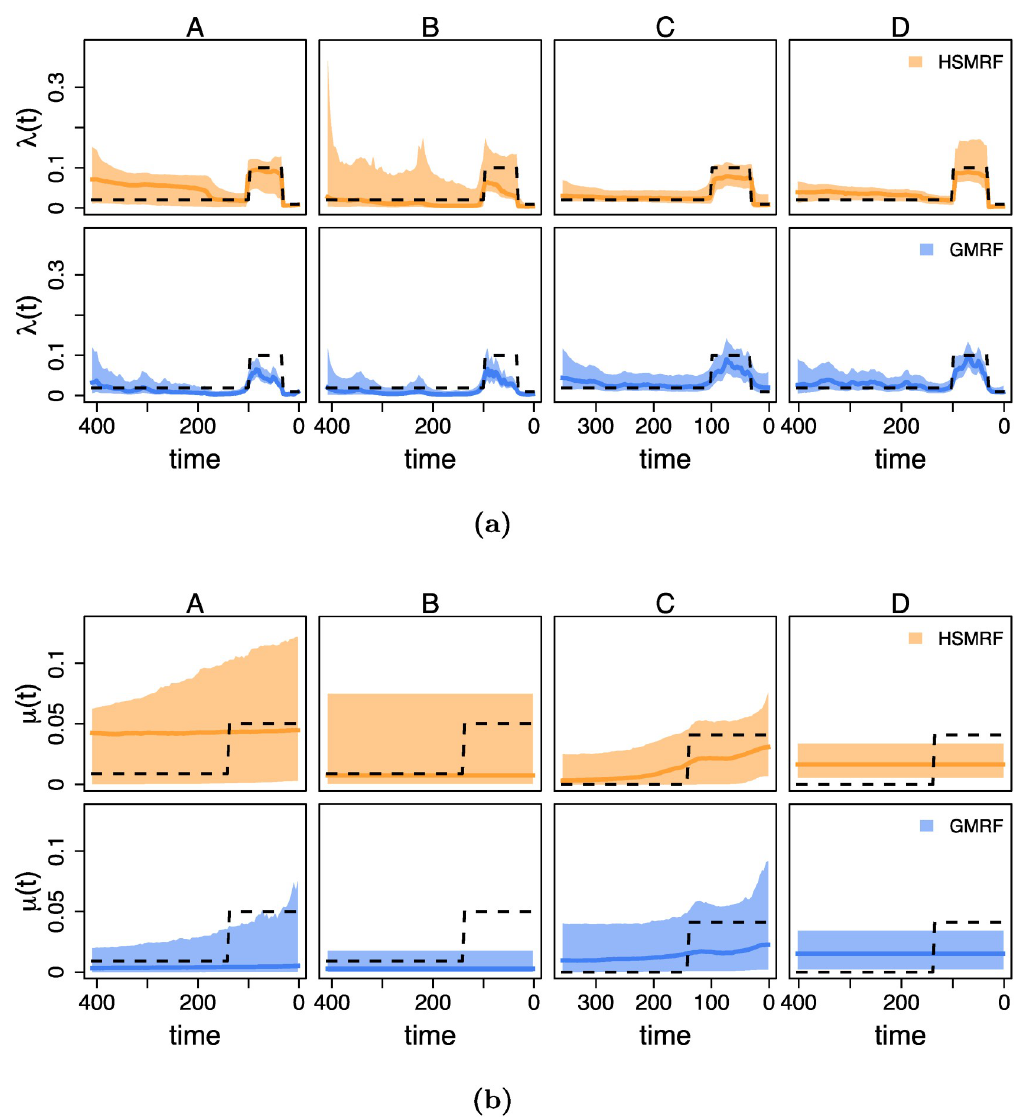
Fig 5. Inferred (a) birth-rate trajectories and (b) death-rate trajectories from four individual simulations with time- varying birth and death rates. The dashed line is the true simulating rate, the dark colored line is the posterior median trajectory (the median is taken separately for each grid cell), and the shaded region shows the 90% Credible Intervals (CIs) for the rate. In each column, we show the simulation with the most average performance measured in terms of the Mean Absolute Deviation of the birth- and death-rate trajectories from both the GMRF and HSMRF (columns are shared across birth-rate and death-rate subfigures). The column labels A, B, C, and D identify the different combinations of tree simulations and analysis setup. A and B are analyses of trees with isochronous sampling, C and D heterochronous sampling. A and C are analyses where time-varying death rate, μ ( t ) is inferred, B and D where a constant death rate, μ , is